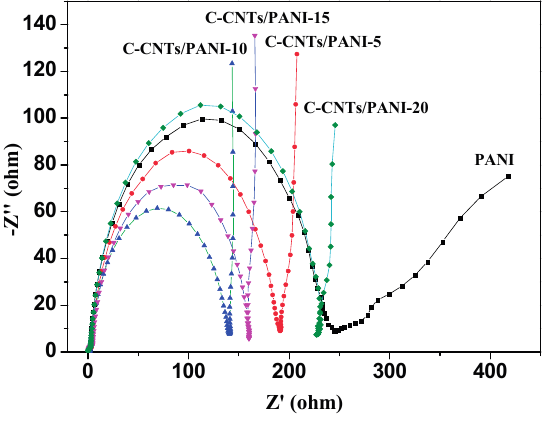
Figure 8. Nyquist plots of the C-CNTs/PANI composite electrodes.